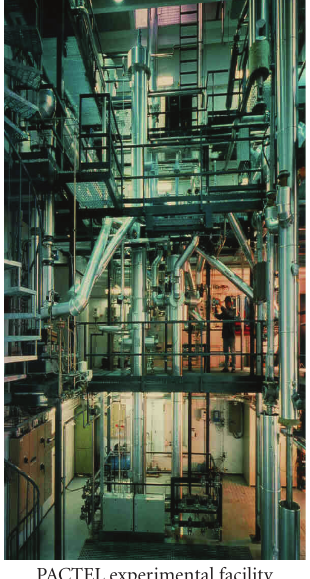
Figure 1: PACTEL experimental